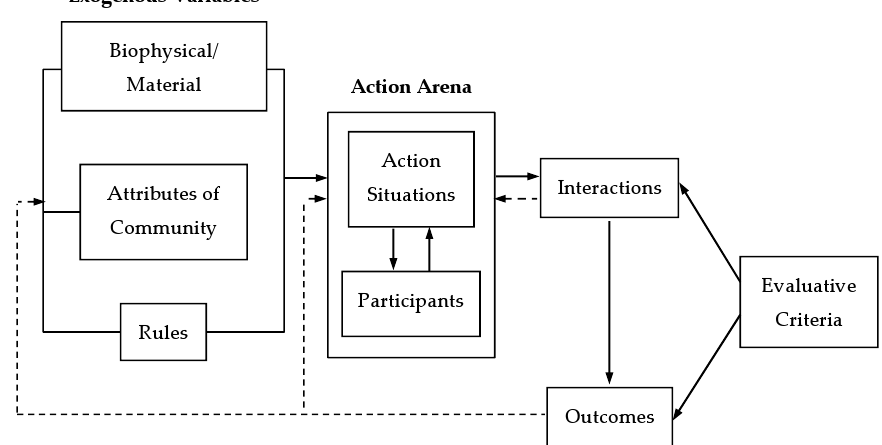
Figure 2. Institutional analytical and development (IAD) framework by Ostrom [13].